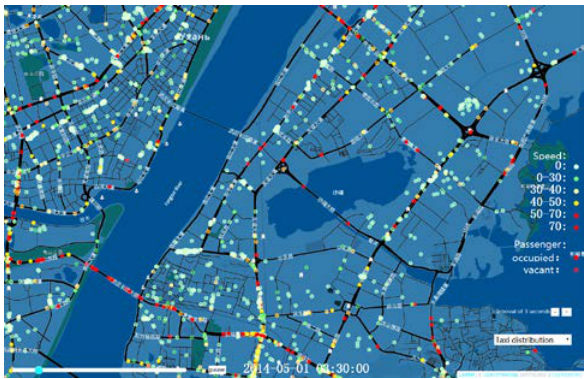
Figure 9 Taxi distribution at 03:30:00 on May 1.